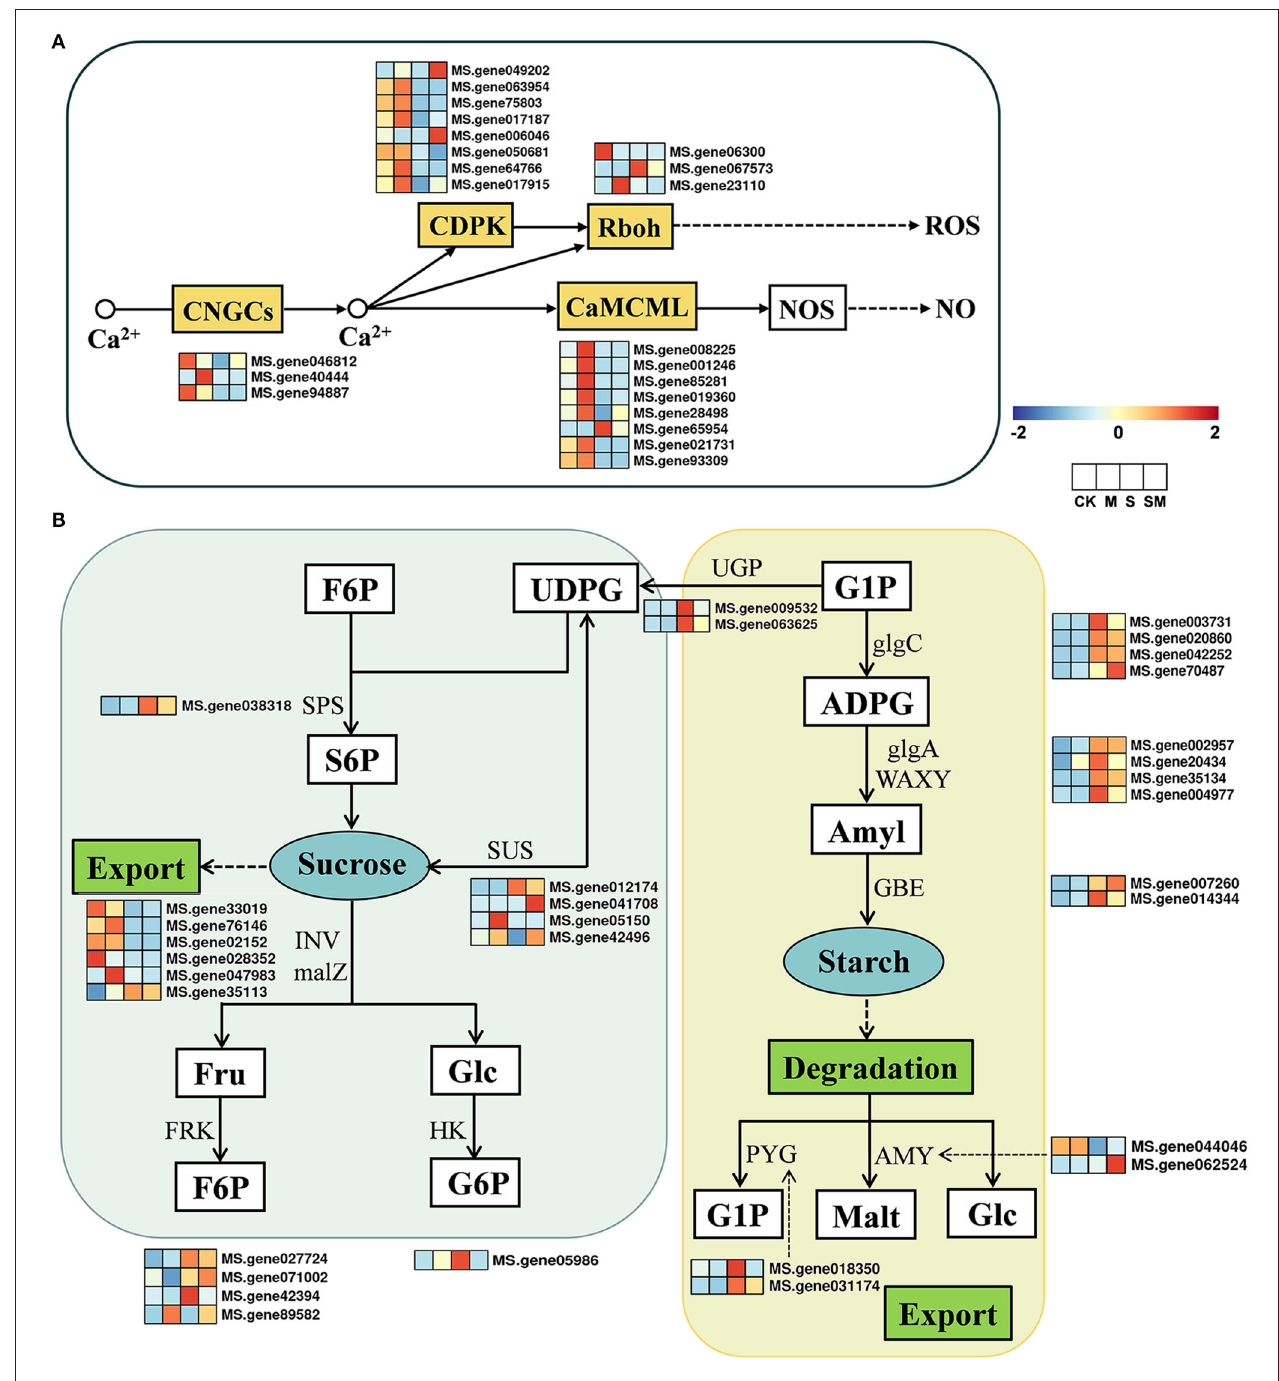
FIGURE 6 | Expression profiles of the key genes involved in (A) Ca 2 + signal pathway and (B) starch and sugar metabolism in response to MT and salt treatment.